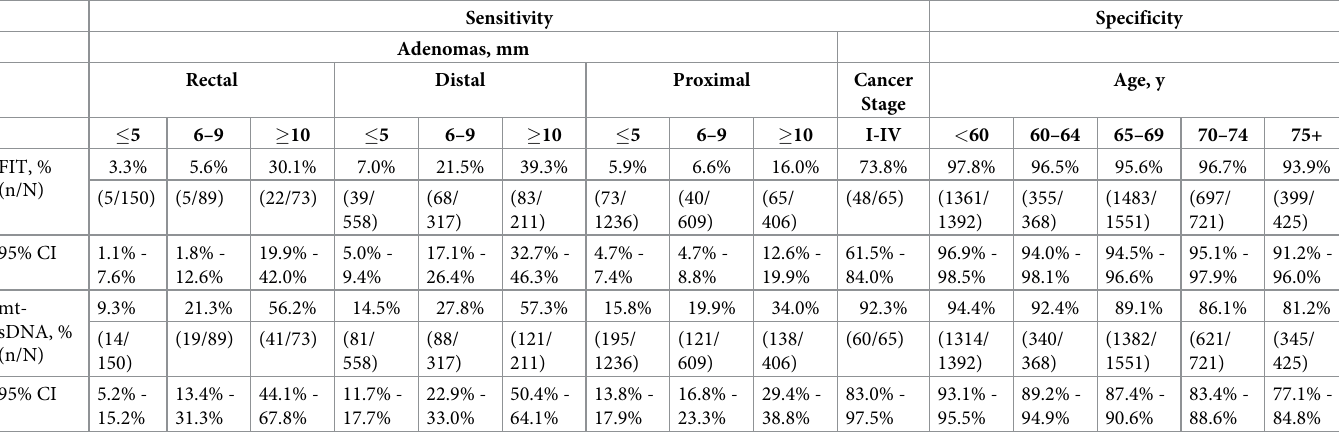
FIT, fecal immunochemical test; mt-sDNA, multitarget stool DNA test. 2-sided 95% confidence intervals calculated using the Exact (Clopper-Pearson)